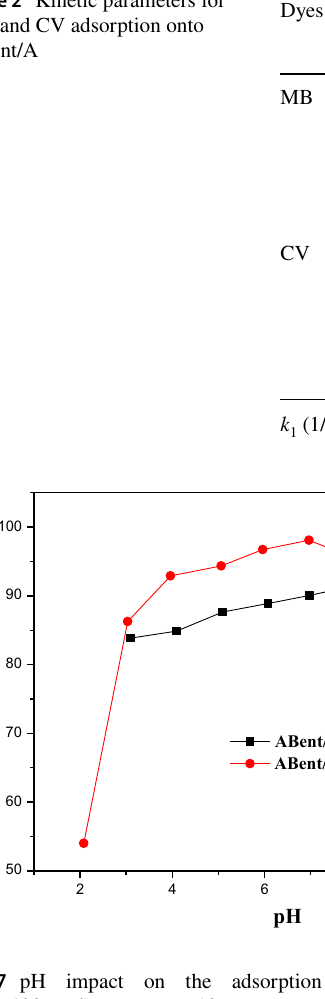
Concentra- Pseudo-first-order tion (mg/L)